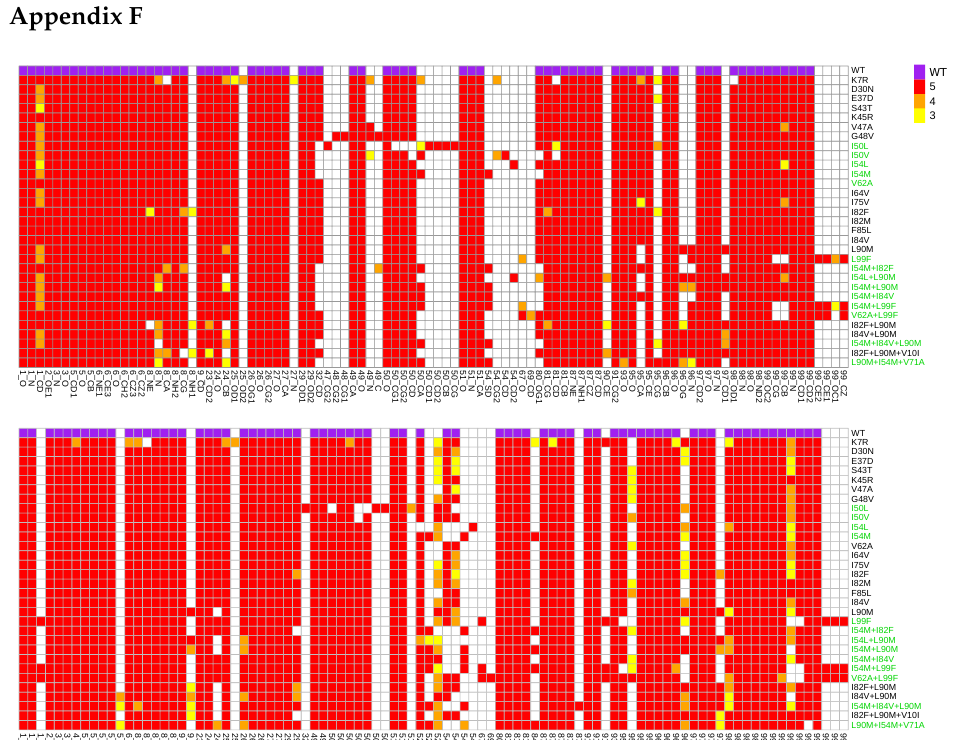
Figure A6. Number of mutant structure where a given atom is involved in the interface. Mutants colored in green present at least a mutation involved in the